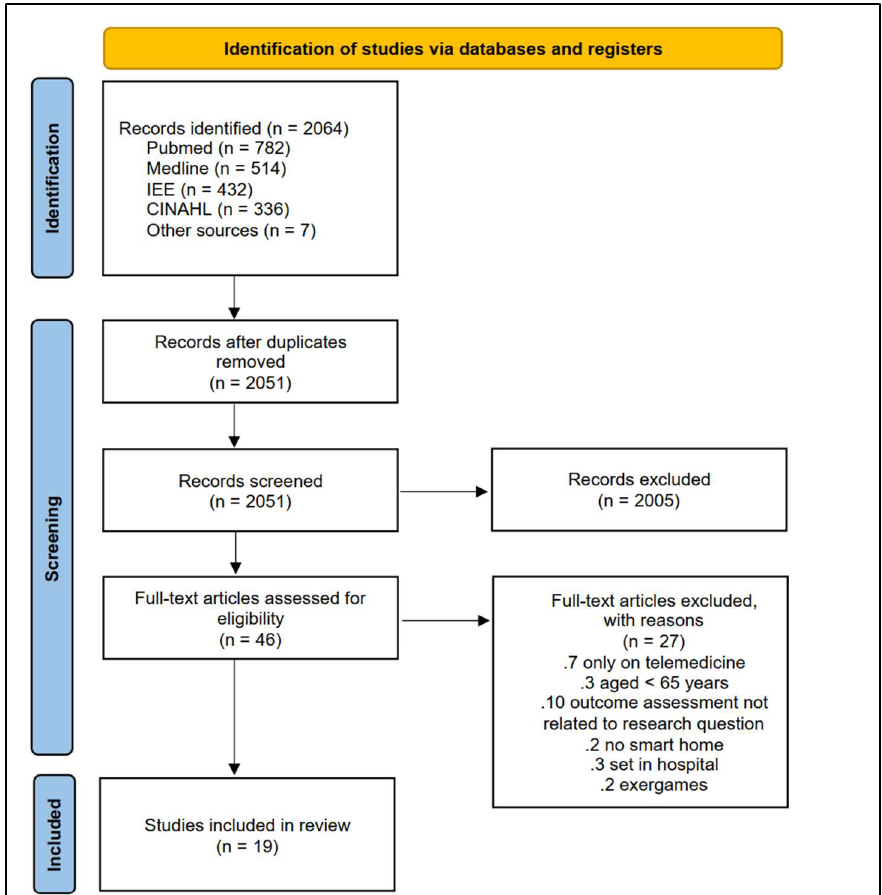
Figure 1. PRISMA flow chart of search strategy.